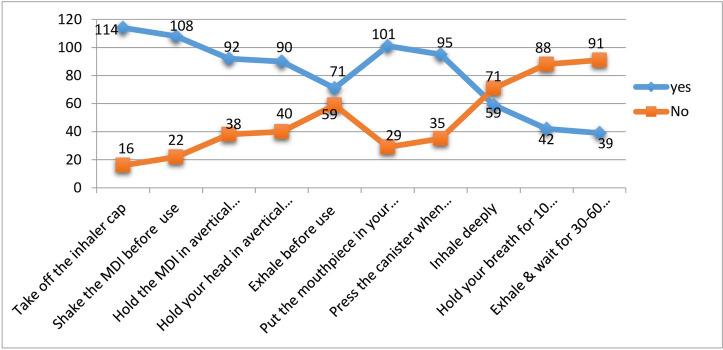
Adherence to the instructions of metered-dose inhalation (MDI) techniques among study participants at JMC, April 20-September 20, 2019.